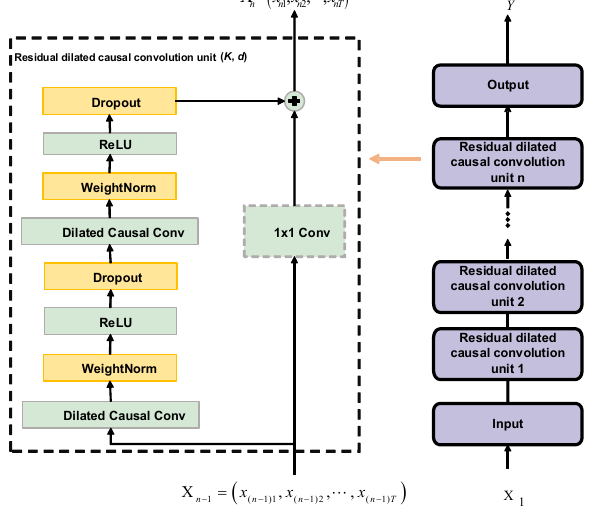
Figure 4. Connection of multiple residual dilated causal convolution units.